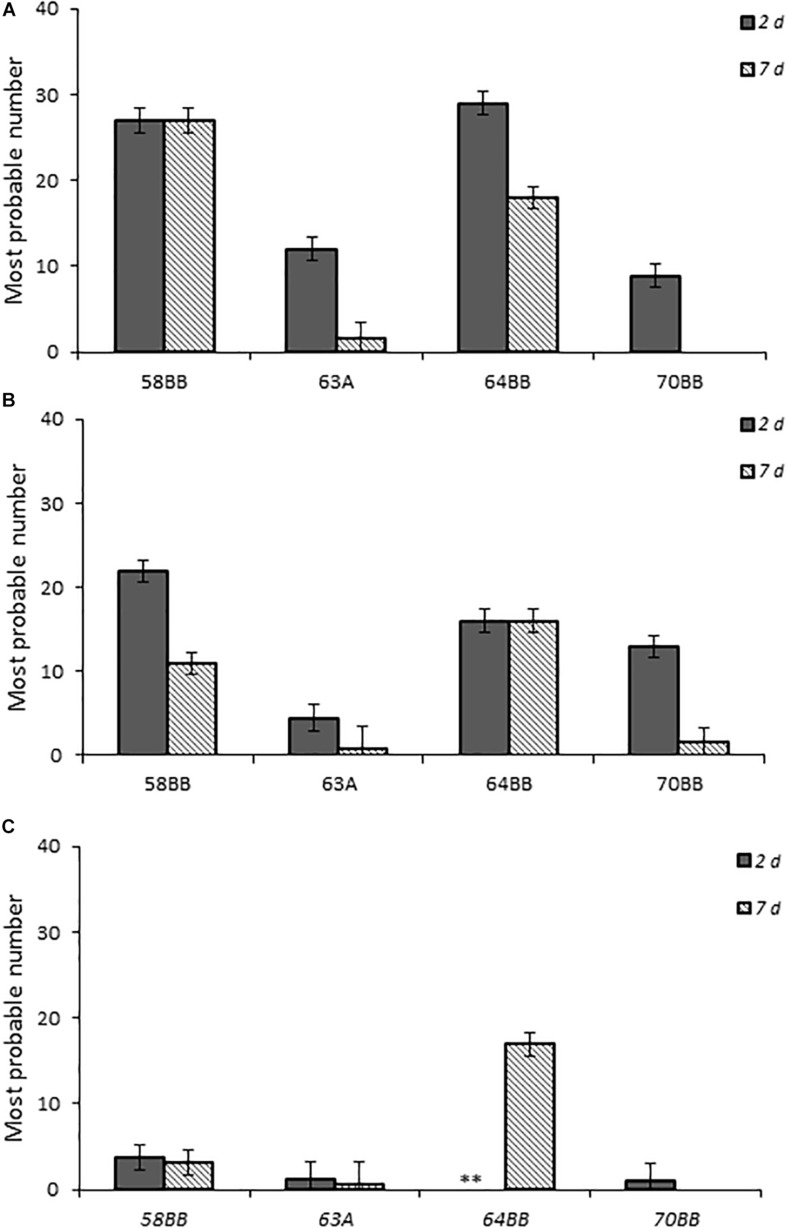
Fecal bacterial burden in chicks infected with Campylobacter jejuni. Environmental isolates at doses (A–C), respectively, as determined by the most probable number (MPN) calculations as described in section “Materials and Methods.”